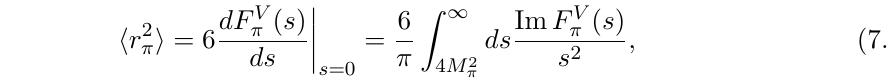
Figure 16. Fit result for the elastic P -wave (cid:25)(cid:25) scattering phase shift (cid:14) 1 the systematic uncertainty due to the parameters in the dispersive form factor representation, while the black error band representing the (cid:12)t uncertainty is hardly visible. Note that, in contrast to (cid:12)gure 3, the band includes the systematic uncertainties related to the asymptotic continuation of the phase